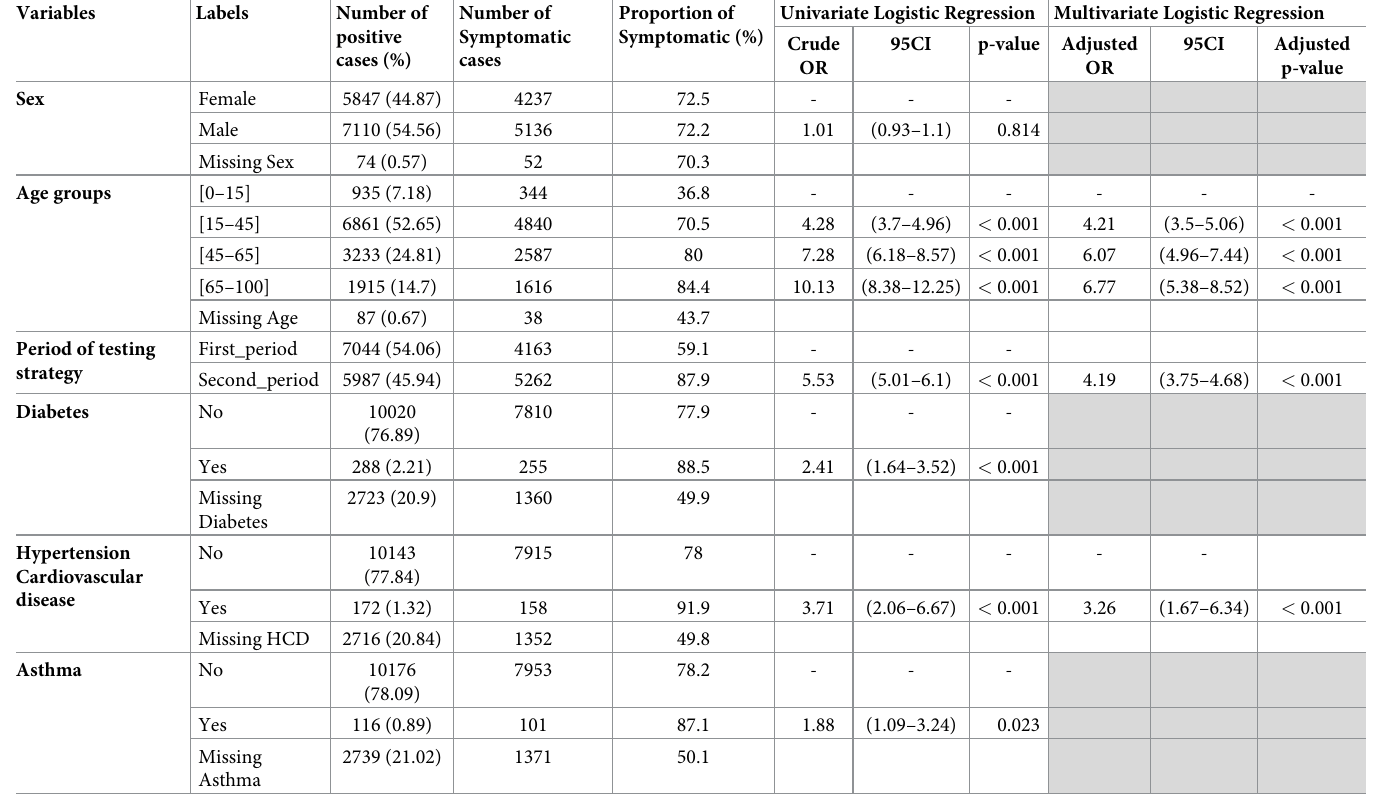
Table 2. Univariate and multivariable factors analysis according to "symptomatic/asymptomatic" status.